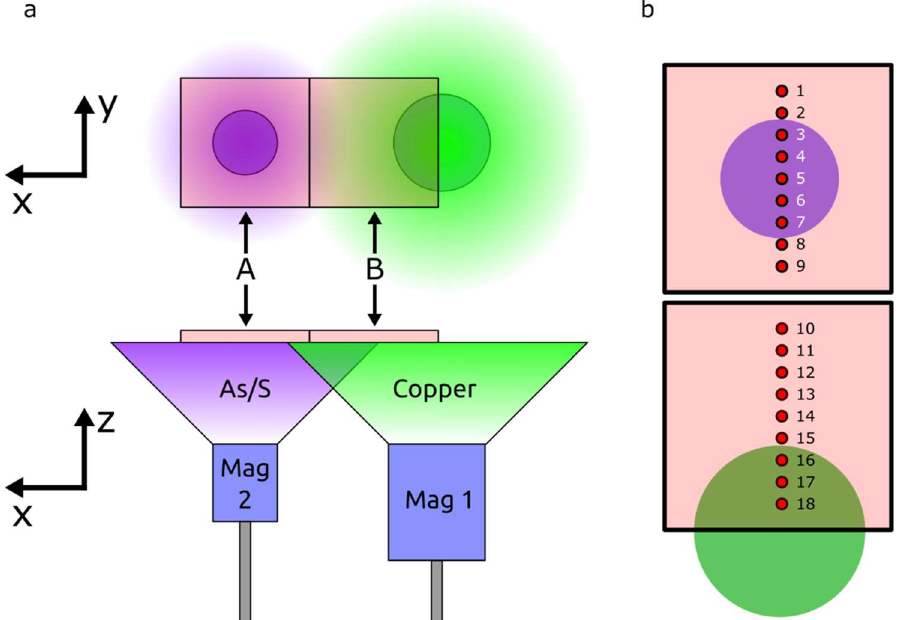
Figure 1. ( a ) Illustration of the co-sputtering system configuration, displaying the relative position of each target and the two glass substrates, from two perspectives (top and side view). The sketch in ( b ) shows the position of the 18 measurement points along two glass substrates, with the indication of the relative position of the targets.